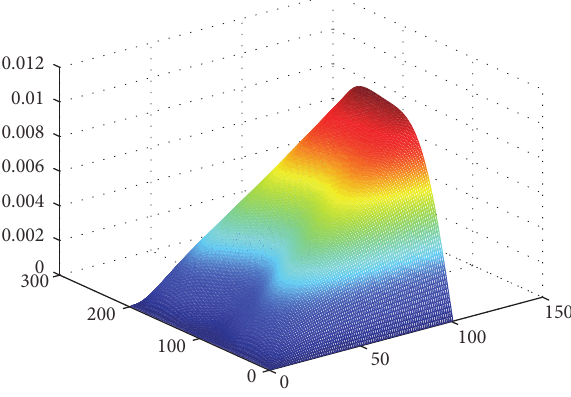
Table 5: Numerical results for Example 1.